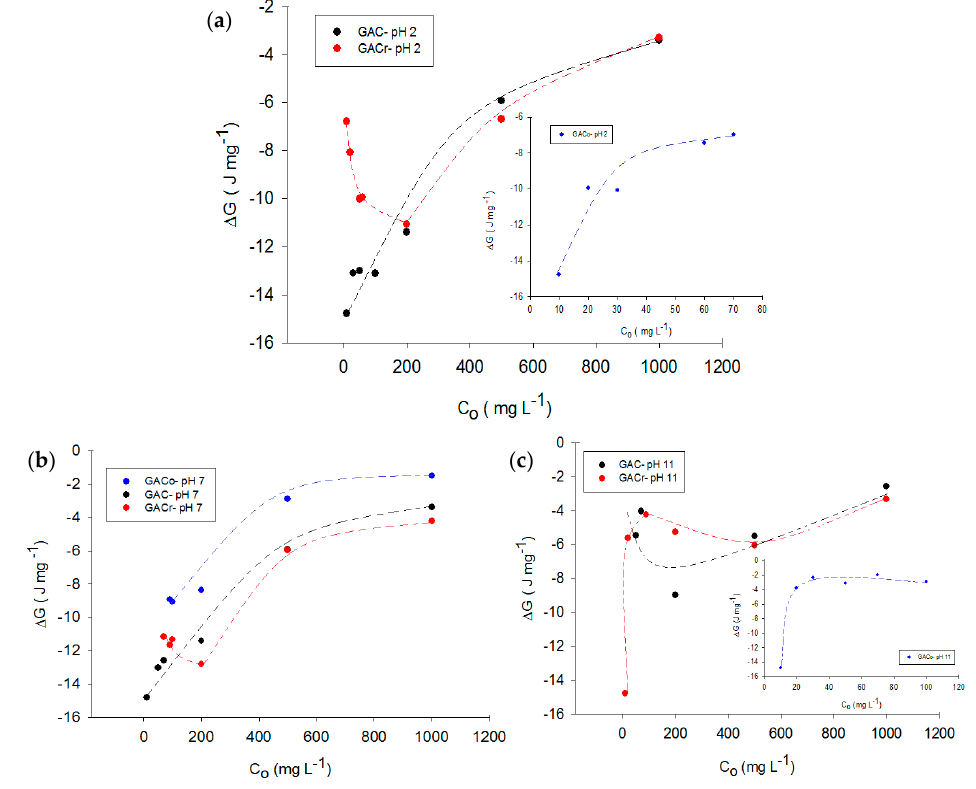
Figure 6. Gibbs energy change for paracetamol adsorption on activated carbons at ( a ) pH 2, ( b ) pH 7 and ( c ) pH 12. Dotted lines represent the process tendency.